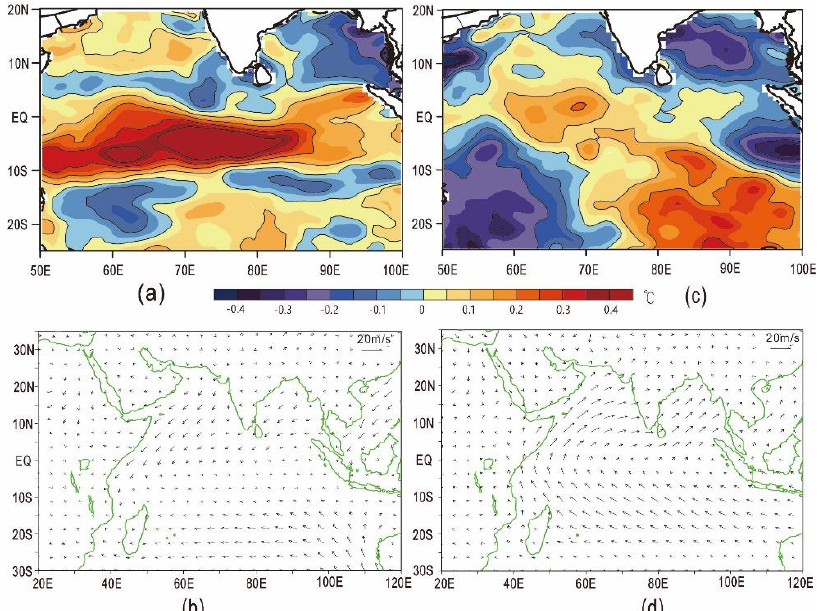
Figure 4. Difference in temperature between the sea and air and the wind field over the Indian Ocean. ( a ) The first pattern of the anomaly in the sea - air temperature difference (sea surface temperature minus the air temperature of two meters above the sea) in January. ( b ) Wind fields at 1000 hPa in January. ( c ) The first pattern of the anomaly in the sea-air temperature difference in July. ( d ) Wind fields at 1000 hPa in July.